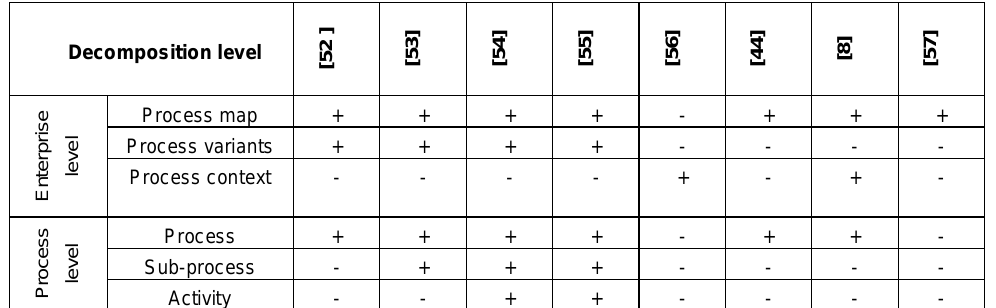
Table 2. The business process d ecomposition